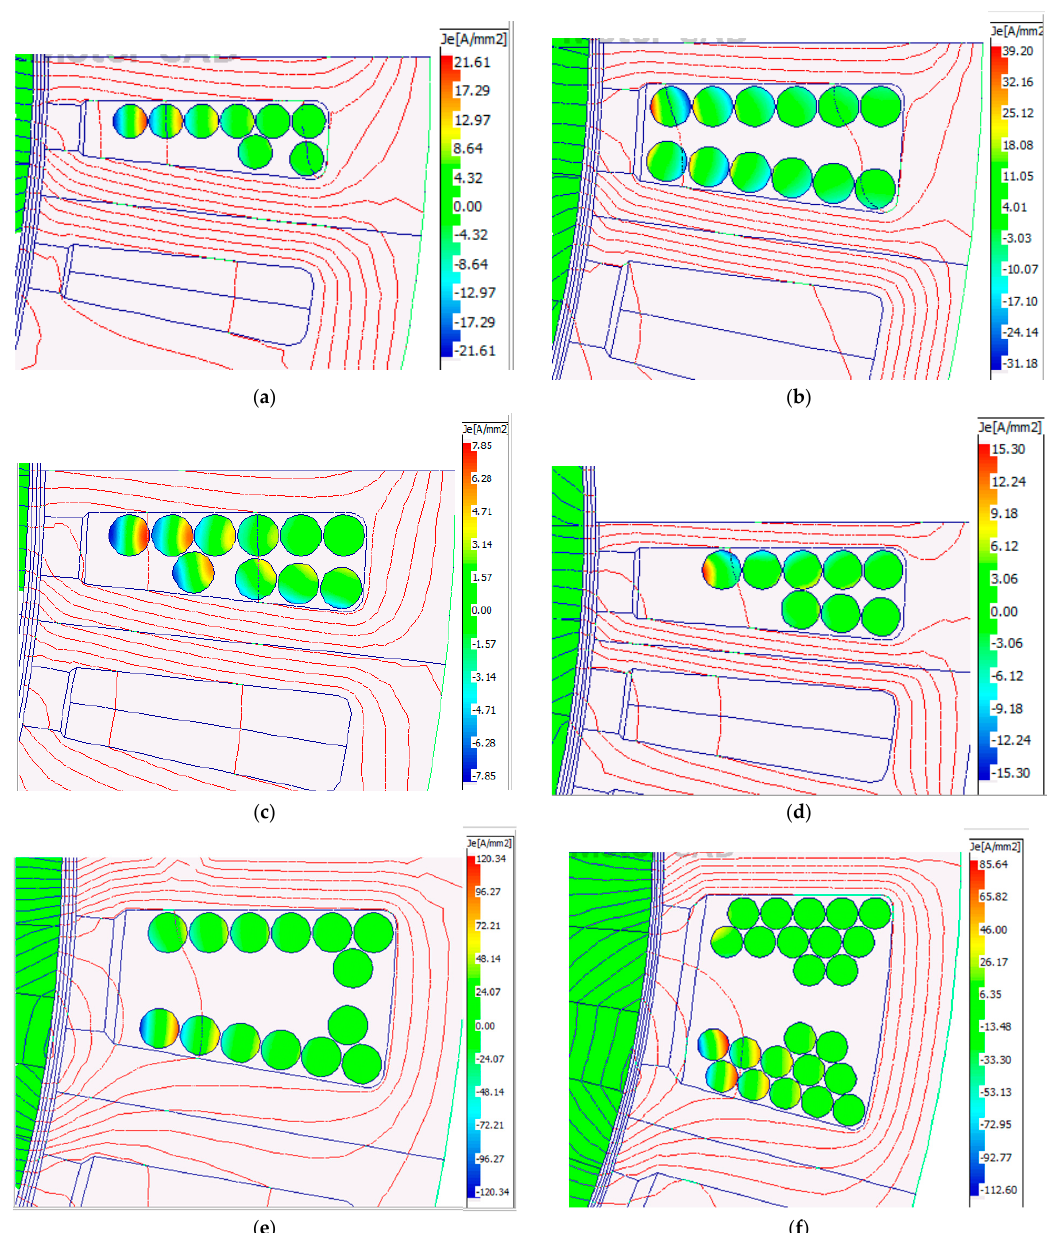
Figure 12. Slot open current density map results for solution ID 27: ( a ) S60 − P20, PAC 5.3 kW, 27% reduction, ( b ) S48 − P16, PAC 8.6 kW, 50% reduction, ( c ) S60 − P16, PAC 8.6 kW, 3% reduction, ( d ) S72 − P22, PAC 7.1 kW, 66% reduction, ( e ) S36 − P30, PAC 11.0 kW, 78% reduction, and ( f ) S24 − P20, PAC 10.6 kW, 72.6%